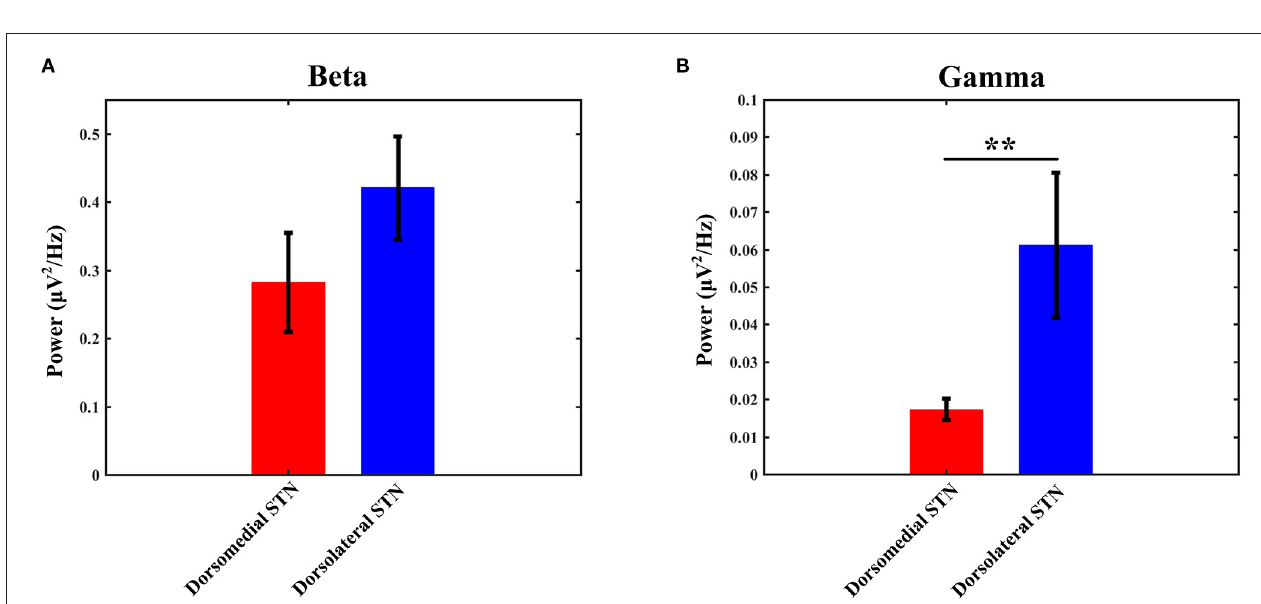
FIGURE 3 | Comparison of beta (A) / gamma (B) power between the dorsomedial and dorsolateral STNs from 18 patients (36 sides). The power for each trial represents the average of the power values across all valid pairs per side. Red bar = dorsomedial STN, blue bar = dorsolateral STN. Error bars represent standard error. Moreover, **denotes statistical significance ( p < 0.01). STN: subthalamic nucleus.